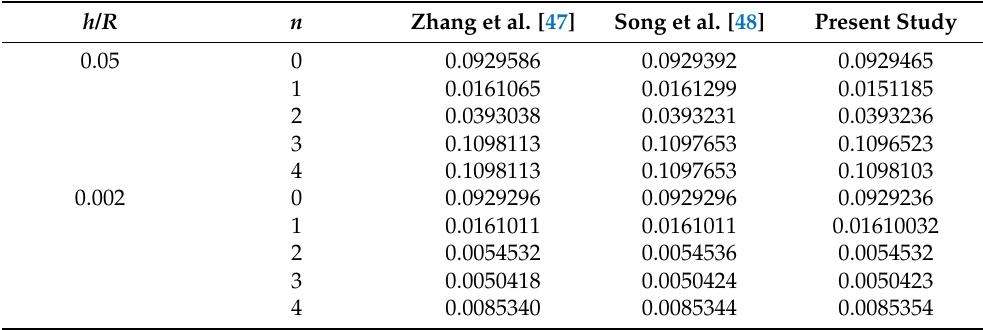
Table 1. Comparison of the frequency parameters ( Ω n = ω n R isotropic cylindrical shell with L / R = 20, m = 1 and ν = 0.3.